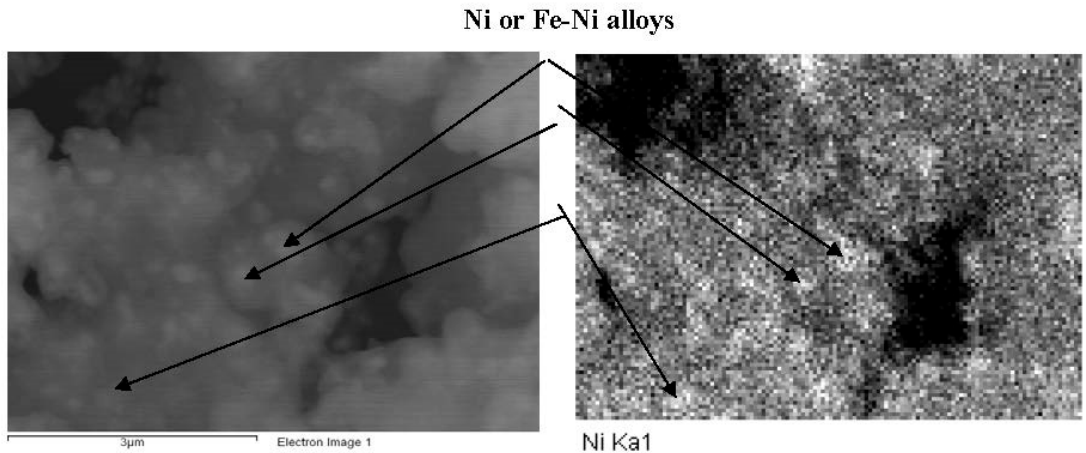
Figure 8. EDX mapping of Ni particles after bio-oil MemU SR ( E = 20 kV). Catalysts 2018 , 8 , 1